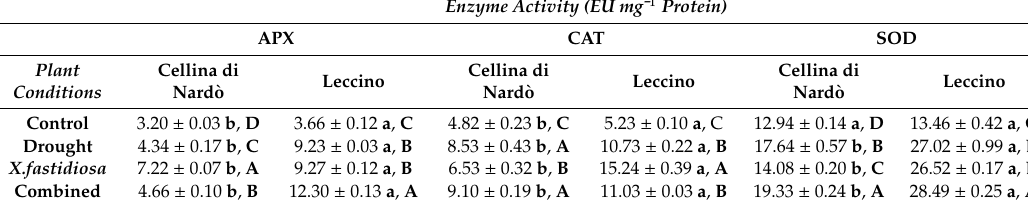
Figure 2. Proline content ( µ mol g FW − 1 ) determined on Cellina di Nard ò and Leccino leaves subjected to individual and combined stresses (drought and Xylella fastidiosa ). Small letter compares the mean of five repetitions (Tukey HSD post hoc test p ≤ 0.05). Top right Two-way ANOVA results were reported. Table 1. Enzyme activities of ascorbate peroxidase (APX), catalase (CAT), and superoxide dismutase (SOD) determined on Cellina di Nard ò and Leccino leaves subjected to individual and combined stresses (drought and Xylella fastidiosa ). Data presented are the means ± SEs ( n = 5). Within rows, means followed by di ff erent low case letters indicate a significant di ff erence ( p ≤ 0.05) among the cultivars , within columns, means followed by di ff erent capital letters indicate a significant di ff erence ( p ≤ 0.05) among the